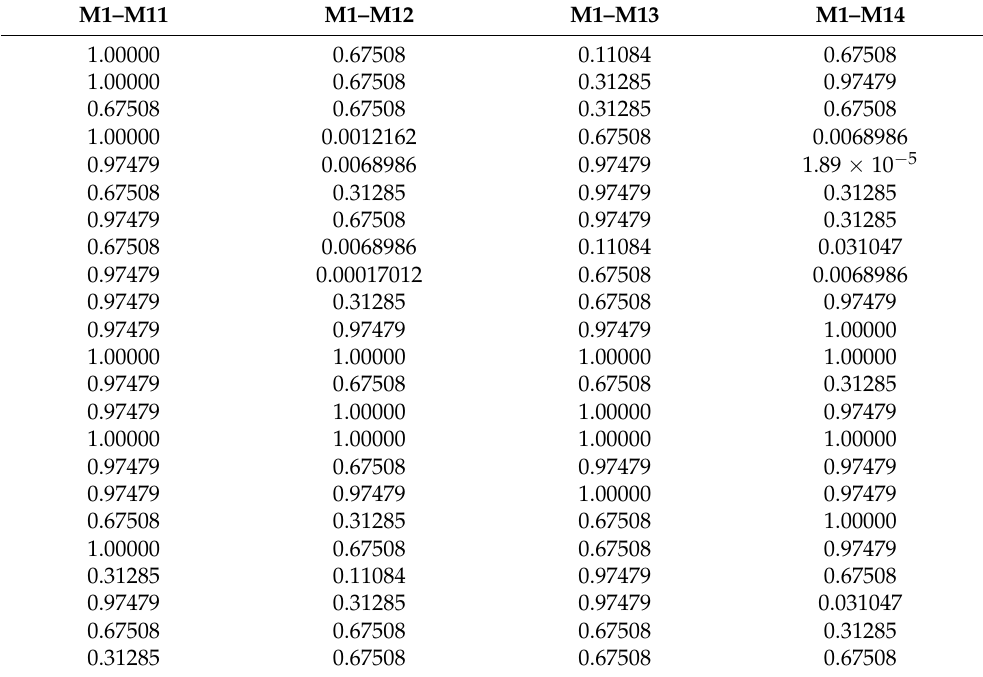
Table A3. p -values of the Kolmogorov–Smirnov test Assumption 3 (constant).